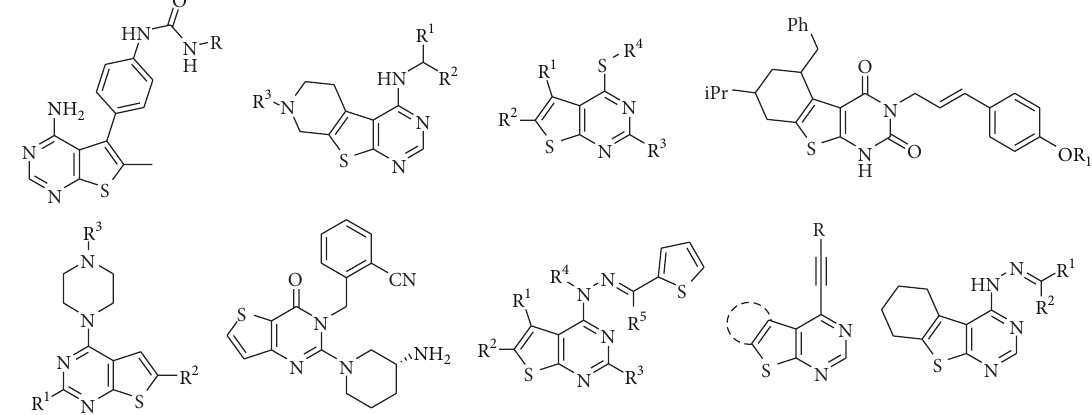
Figure 1: Representative active compounds containing thieno[2,3- d ]pyrimidinone core.